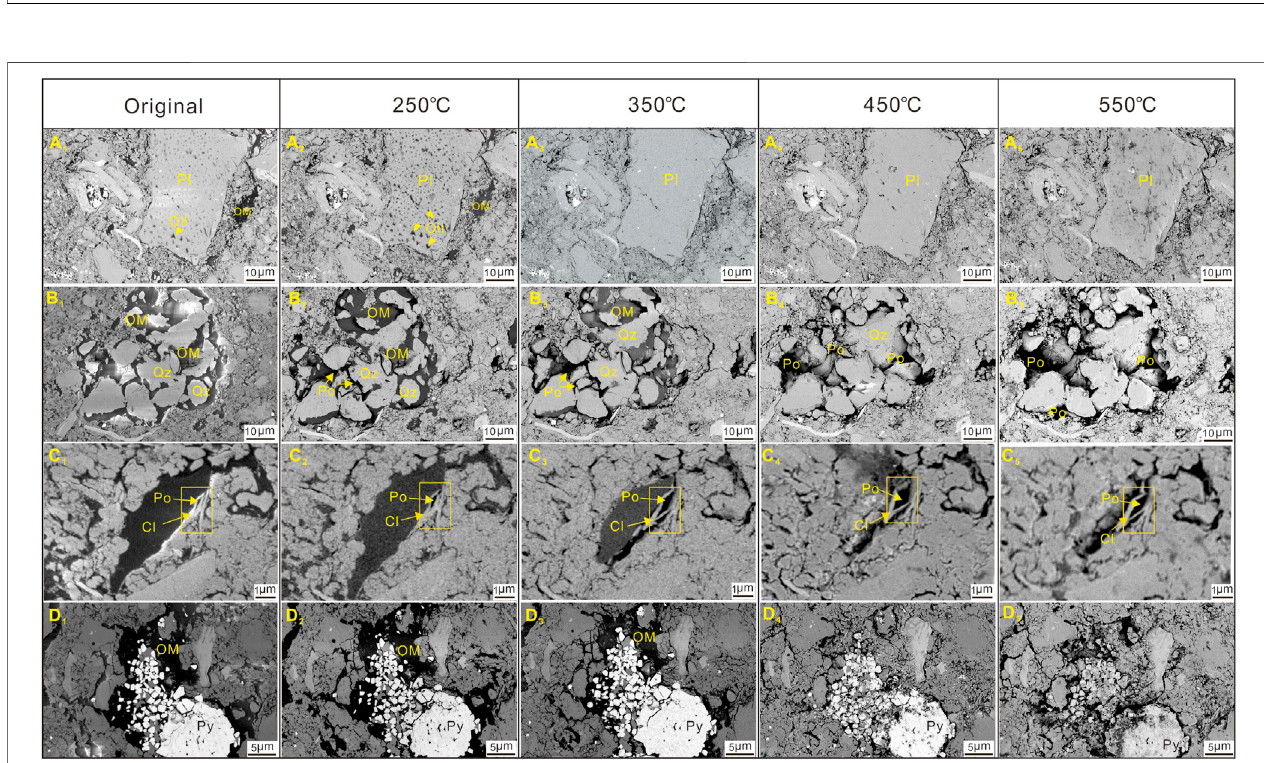
FIGURE 5 | SEM images of different minerals at different temperatures. (A) series are plagioclase, (B) series are quartz, (C) series are clay minerals, (D) series are pyrites. Pl-plagioclase, Qz-quartz, OM-organic matter, Po-pore, Cl-clay minerals, Py-pyrites.